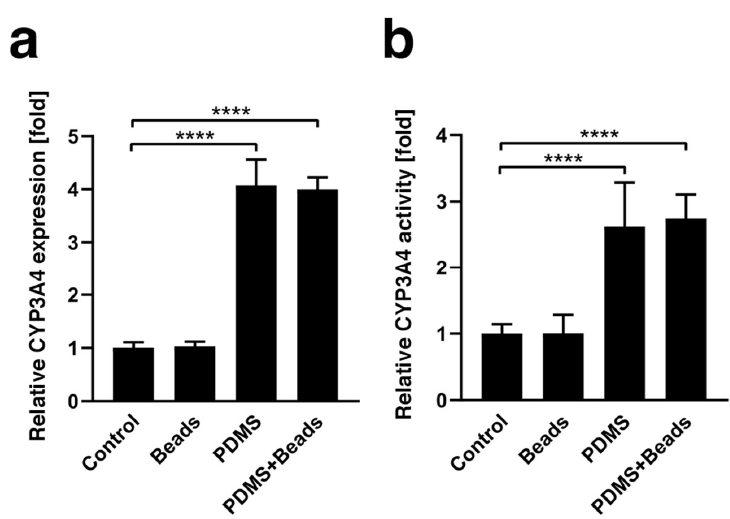
Figure 3. Gene expression and activity of CYP3A4. ( a ) CYP3A4 mRNA expression under Control, Beads, PDMS and PDMS + Beads conditions was measured by qPCR using spheroids at culture day 1. The results were normalized by the expression of GAPDH mRNA and are presented as the fold-difference compared with that of the Control condition. ( b ) CYP3A4 enzyme activity under each condition was measured at day 1 and is presented as the fold-change compared with the Control condition. **** p < 0.0001.